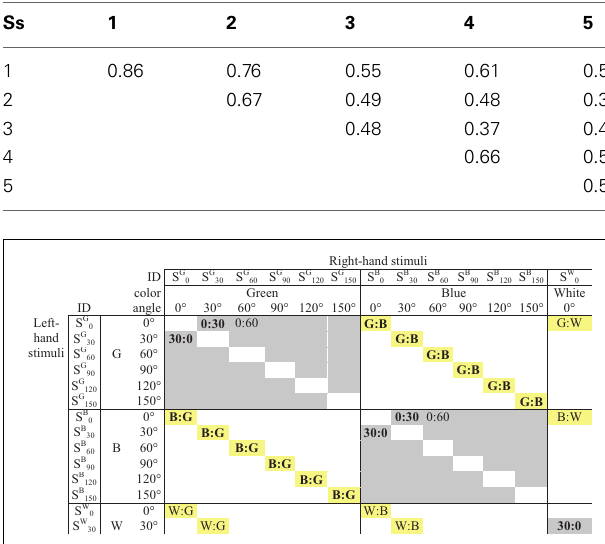
3. 600 bimodal pairs (S a